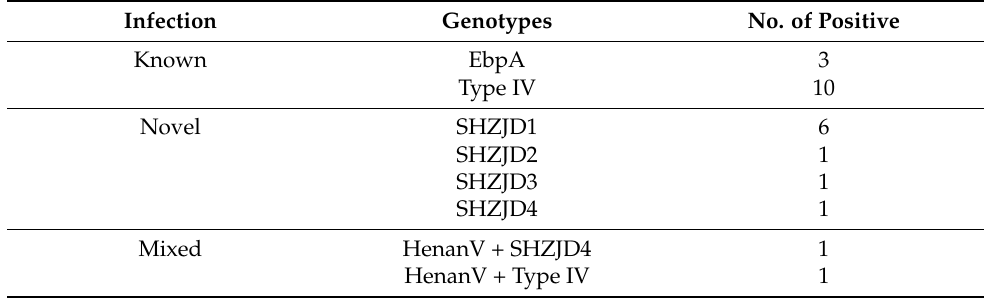
Table 1. Prevalence and genotype distribution of E. bieneusi isolates of stray dogs in Shanghai.